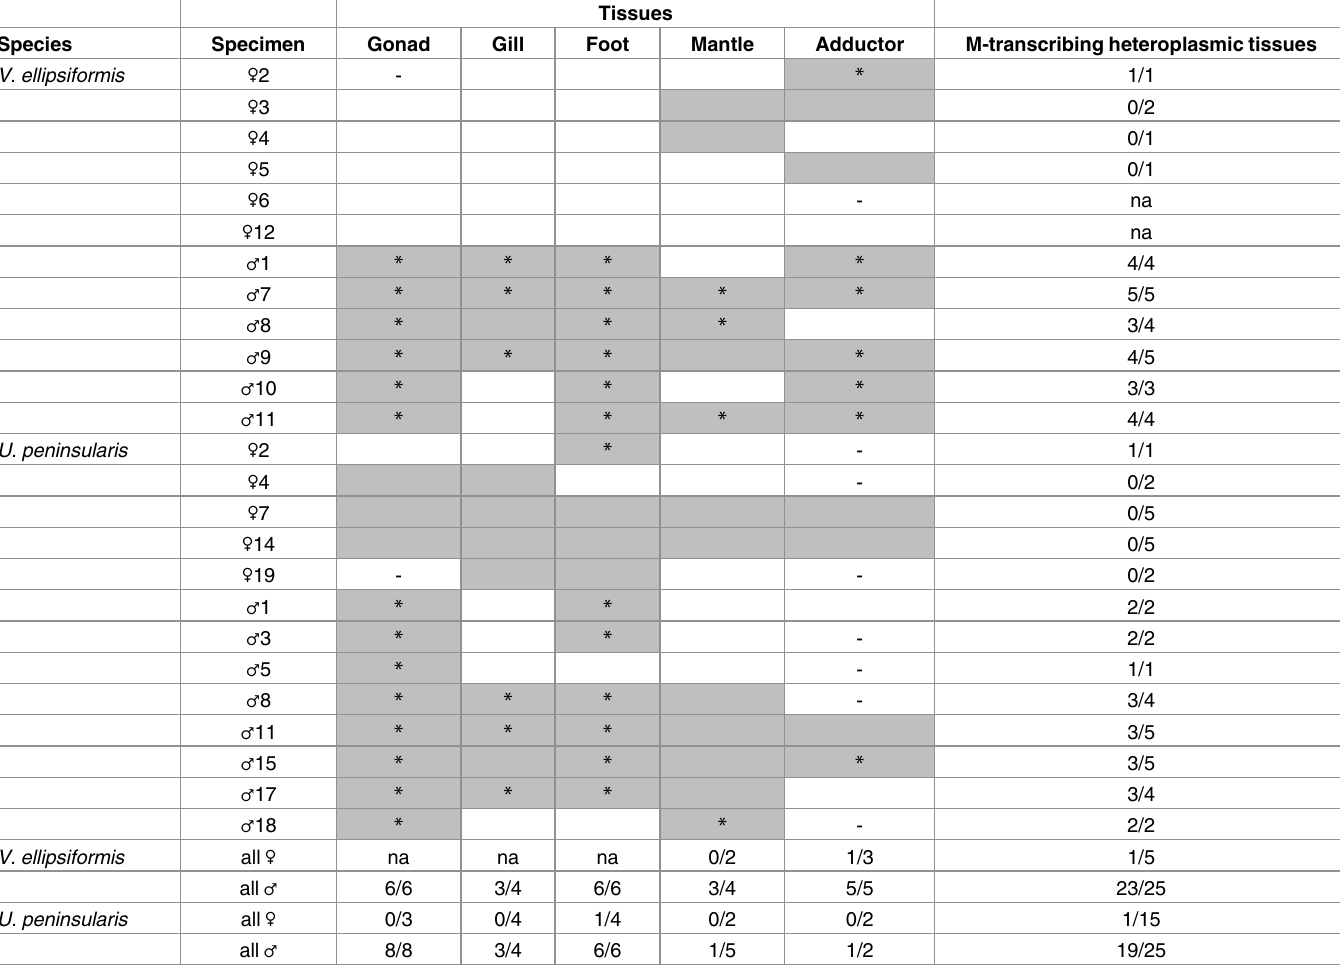
Table 3. Results of the PCR experiments performed on total cDNA from all somatic heteroplasmic tissues of V . ellipsiformis and U . peninsularis .